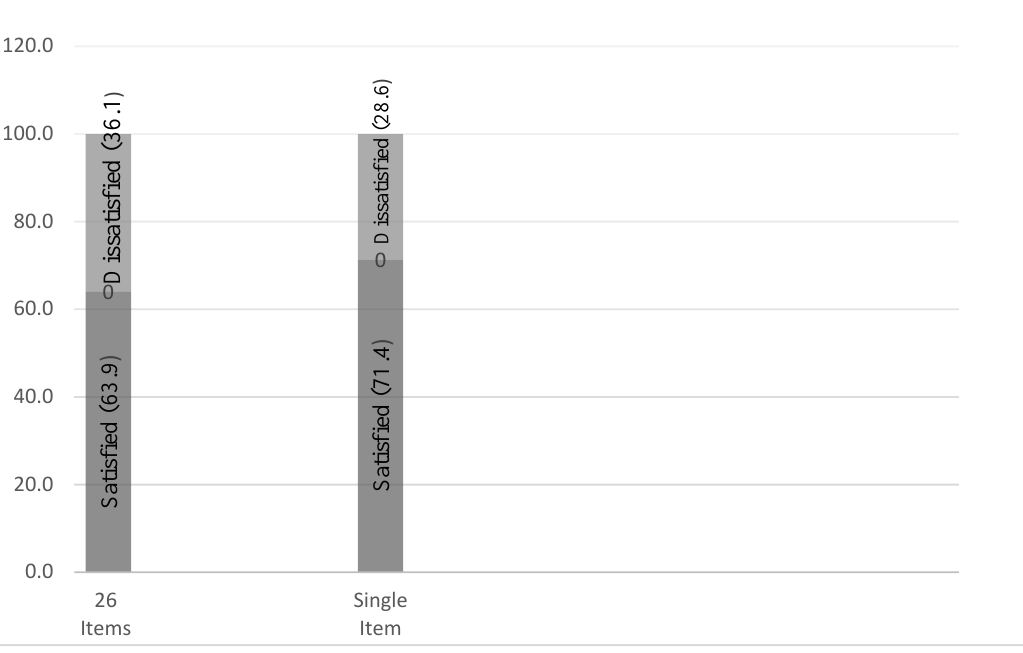
Figure 6. Satisfaction of respondents.